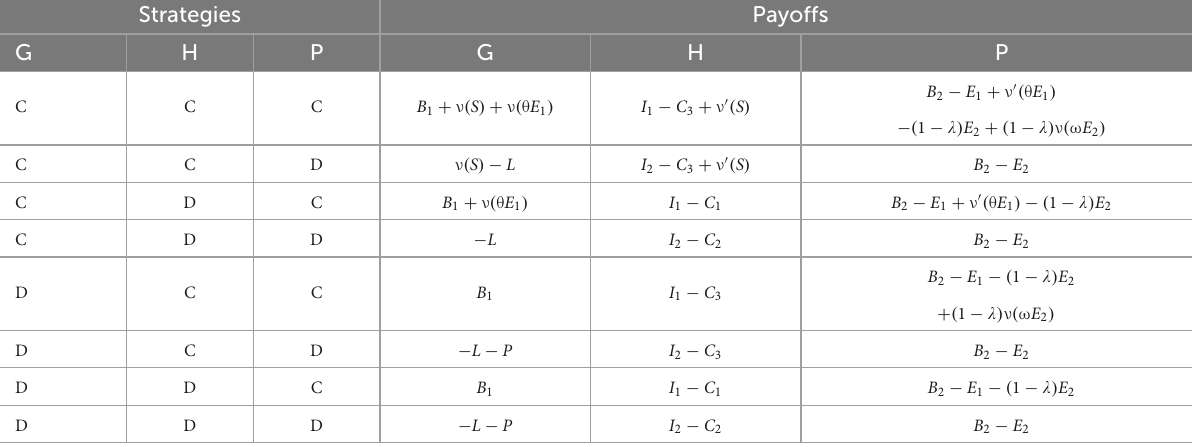
TABLE 1 Payoff matrix of the tripartite evolutionary game in the promotion of